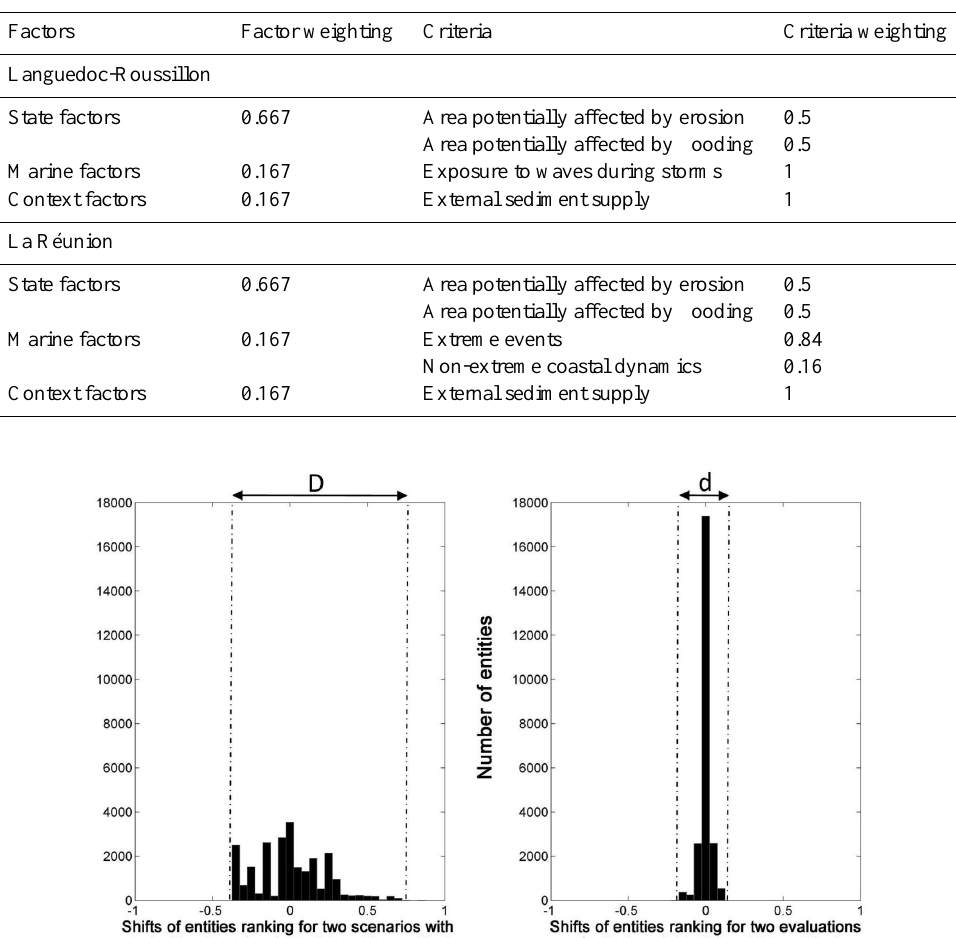
Table 5. Hierarchical tree and associated weighting used for Languedoc-Roussillon. The criteria weighting are obtained by applying AHP similar to the example in Table 2.